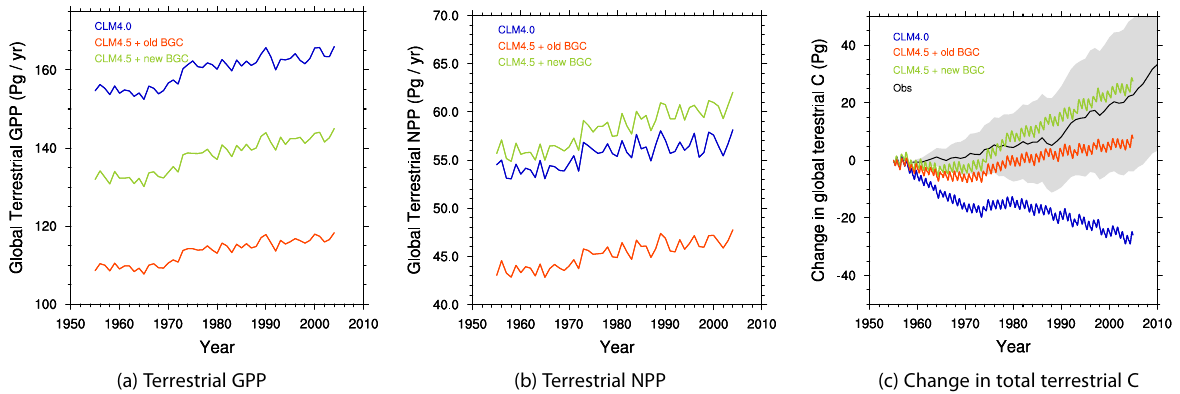
Fig. 13. Changes to global integrated carbon cycle quantities during a transient late-20th-century (1955–2005) model simulation forced by reanalysis meteorology and observed atmospheric CO 2 concentrations. (a) Gross primary productivity (GPP). (b) Net primary productivity (NPP). (c) Change from initial total terrestrial carbon stocks. Observations in (c) are the sum of the land sink and land-use fluxes from the Global Carbon Project (Le Quere et al., 2013), with errors calculated assuming that within each year the land error equals the root-sum- of-squares of the ocean and fossil fuel errors, and that errors are correlated interannually, so are additive in time. Model versions are